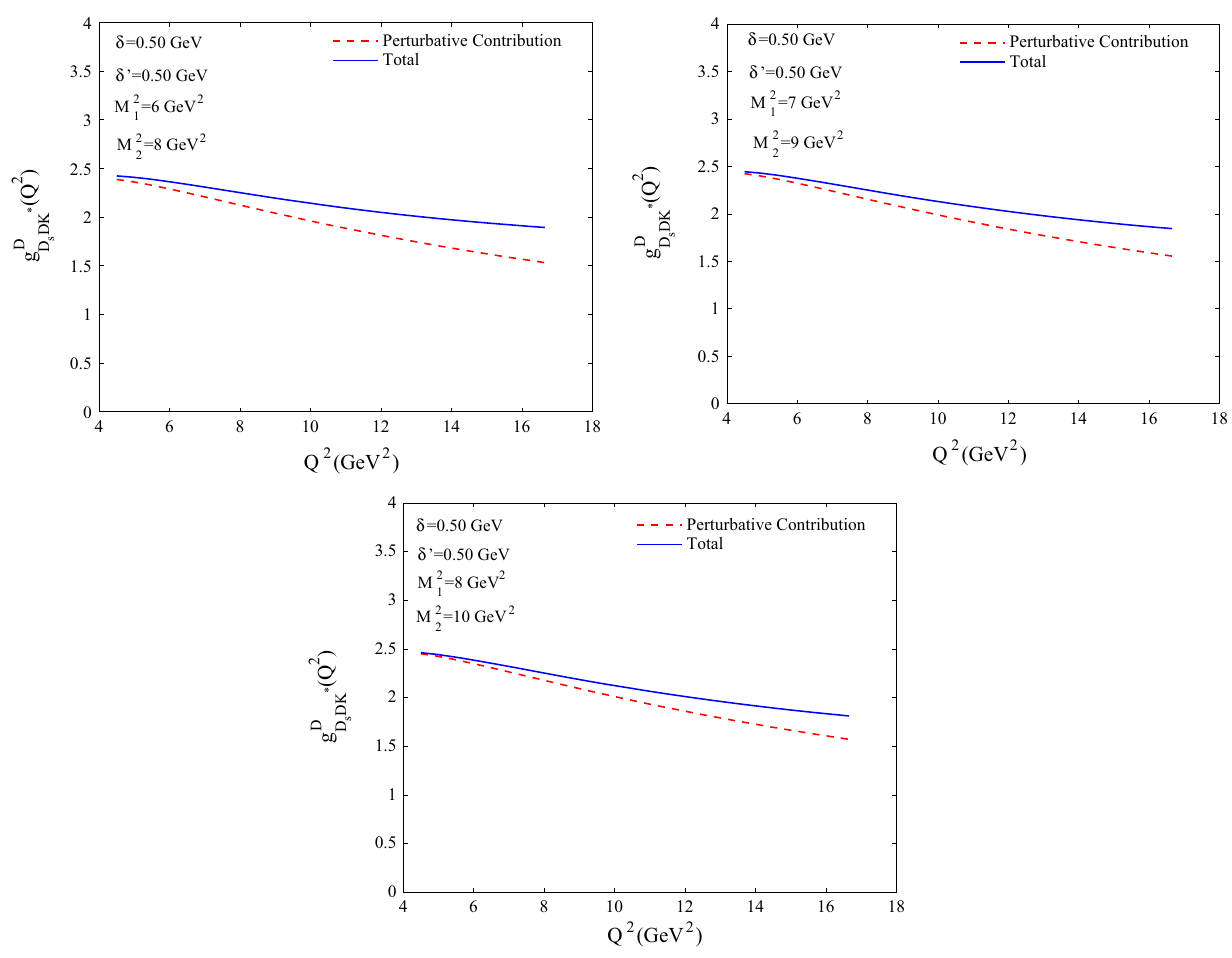
Fig. 6 The strong form factor g D